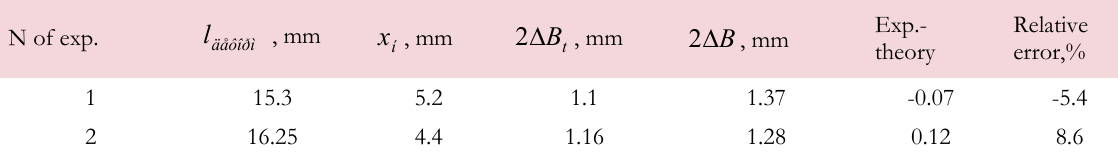
Table 4: The results of theoretical calculations.